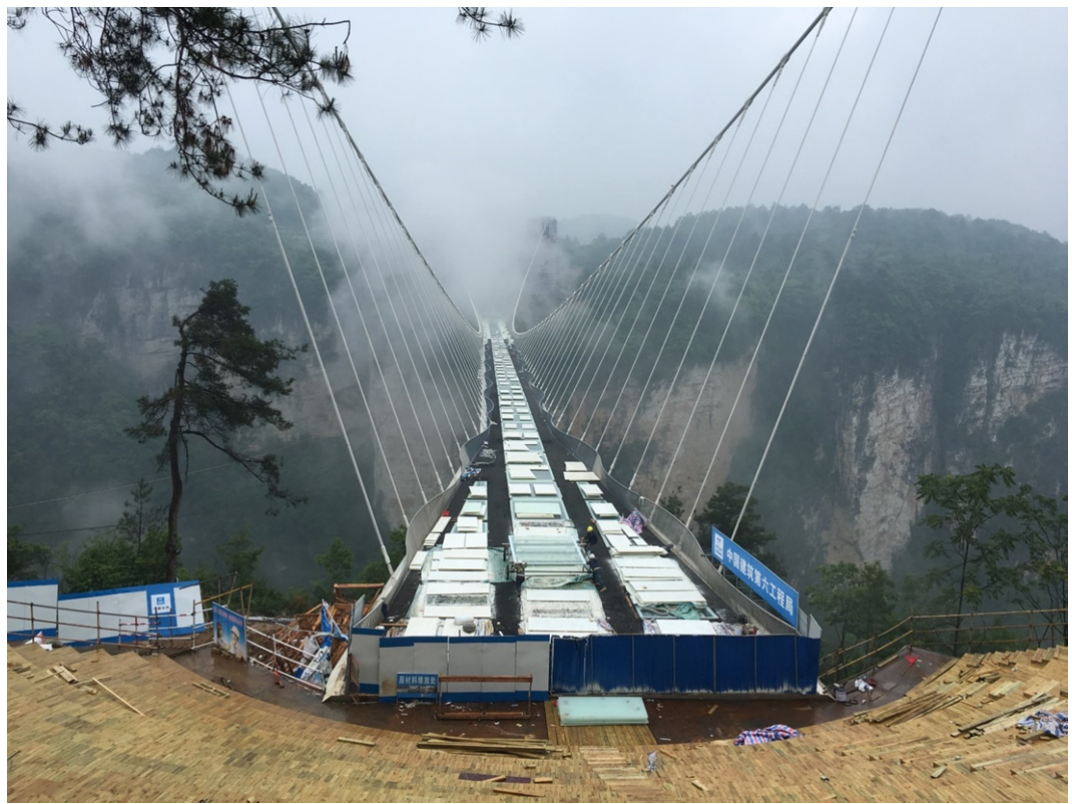
Fig. 8 Zhangjiajie bridge under construction, fronta